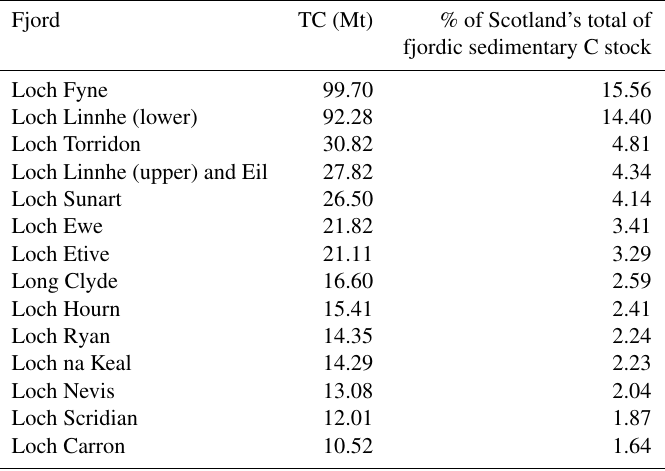
Table 4. Details of the 14 fjords that disproportionately contribute to Scotland’s fjordic sedimentary C stock.